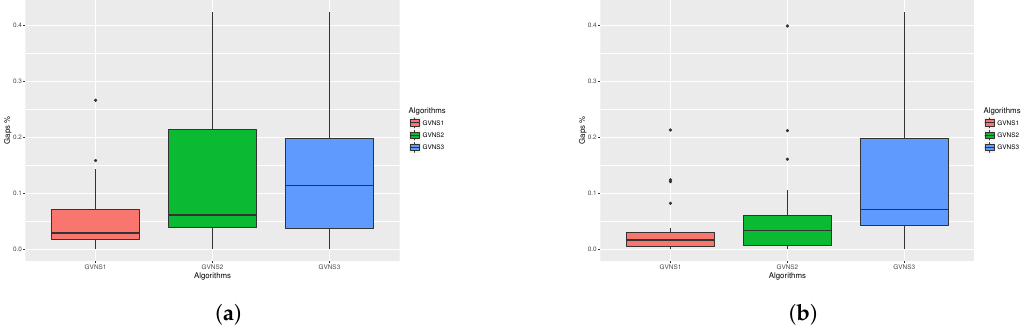
Figure 1. Statistical test for aTSP (1/2). ( a ) Statistical test box plots for aTSP 1min FI; ( b ) Statistical test box plots for aTSP 1min